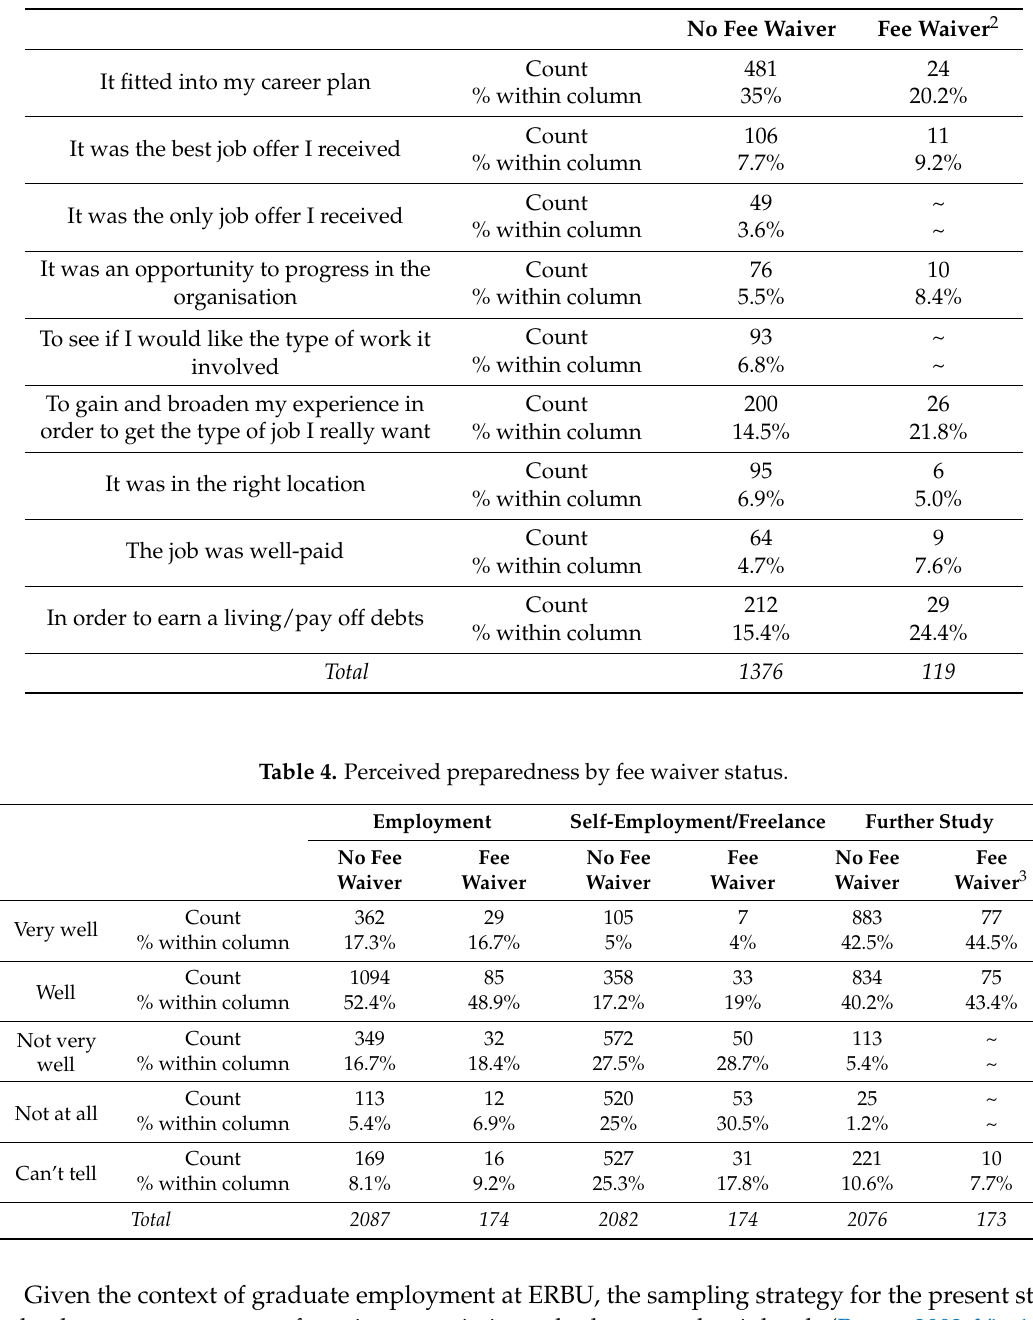
Table 3. Main reason for taking the job by fee waiver status.